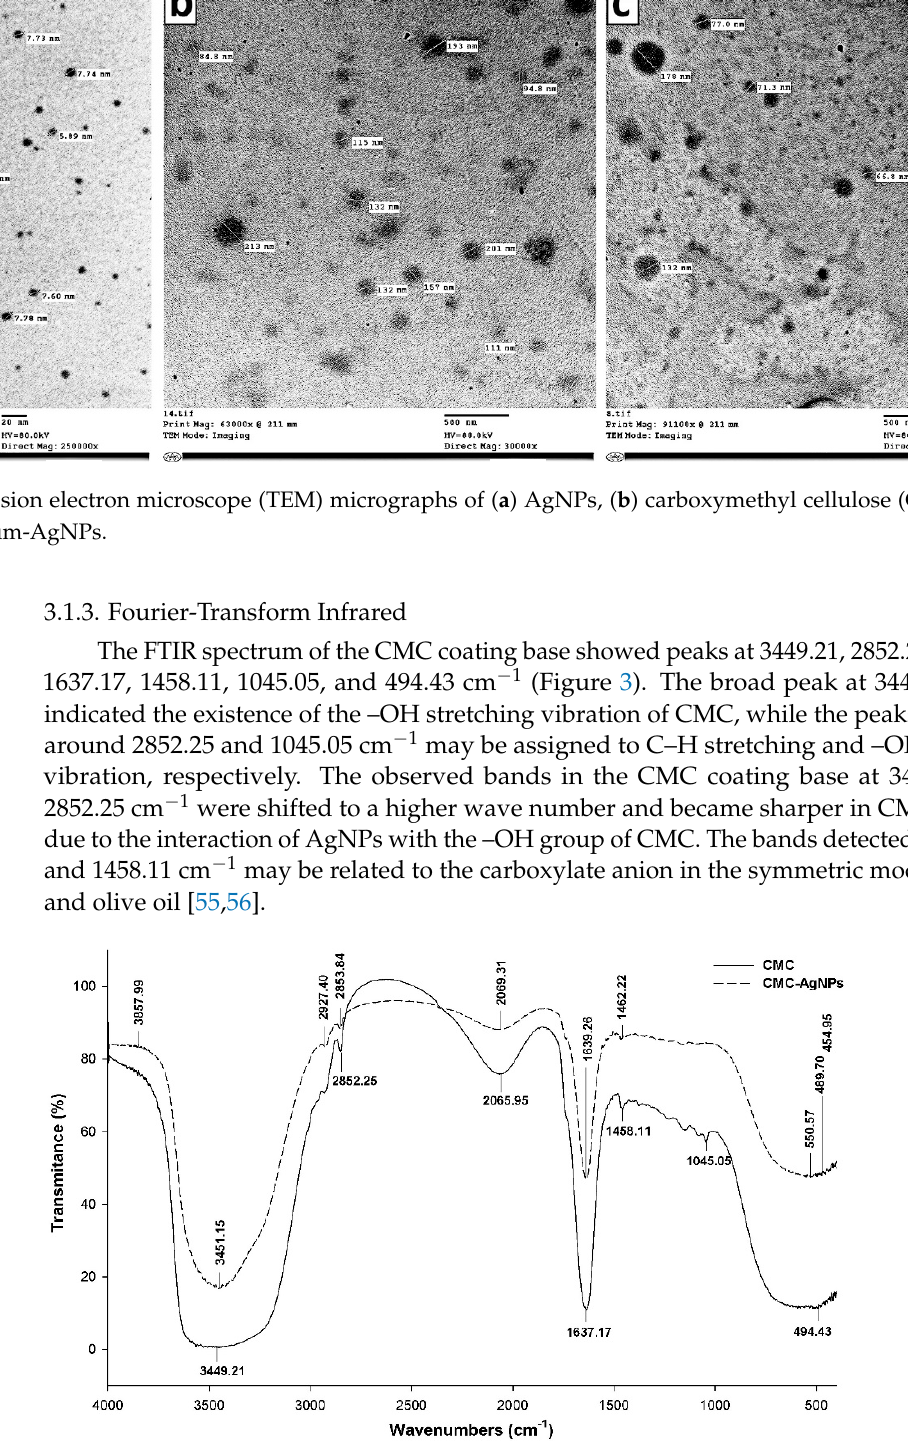
Figure 4. FTIR spectra of guar gum coating base (solid line) and guar gum-AgNPs (dashed line). 3.2. Fruit Quality Attributes 3.2.1. Weight Loss Mango fruit weight loss increased progressively in all treatments over the storage period of 28 days, as shown in Figure 5. The weight loss values were significantly af- fected by storage period ( α ≤ 0.05). The regression analysis showed that the fruit weight loss followed a linear increment during fruit storage. The high value of coefficient of de- termination indicated the existence of a strong relationship between weight loss and storage period (Table S1, Supplementary Materials), and the slope of the weight loss re- gression equation was higher in the control treatment ( β 1 = 0.7304; R 2 = 0.9987) than for fruits coated with CMC-AgNPs ( β 1 = 0.5973; R 2 = 0.9995) and guar gum-AgNPs ( β 1 = 0.5043; R 2 = 0.9994). However, coatings markedly controlled weight loss during storage, particularly with the guar gum-AgNP coating compared to CMC-AgNP coating and uncoated fruits (control) over the storage period. Maximum weight loss was observed in uncoated fruits (20.48%) after 4 weeks of storage at 13 °C, while, on the same date, the weight loss values of coated fruits with CMC-AgNPs and guar gum-AgNPs were 16.57%